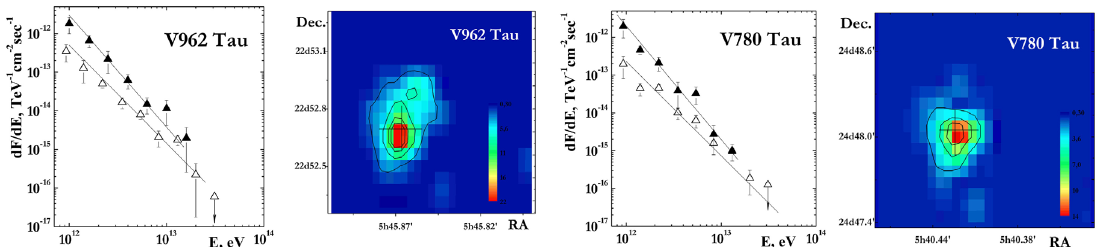
Figure 3. V962 Tau and V780 Tau di ff erential spectra and images by SHALON (see text). Figure 2. V388 Cas and V1589 Cyg di ff erential spectra and images by SHALON (see text). 2.3 V962 Tau and V780